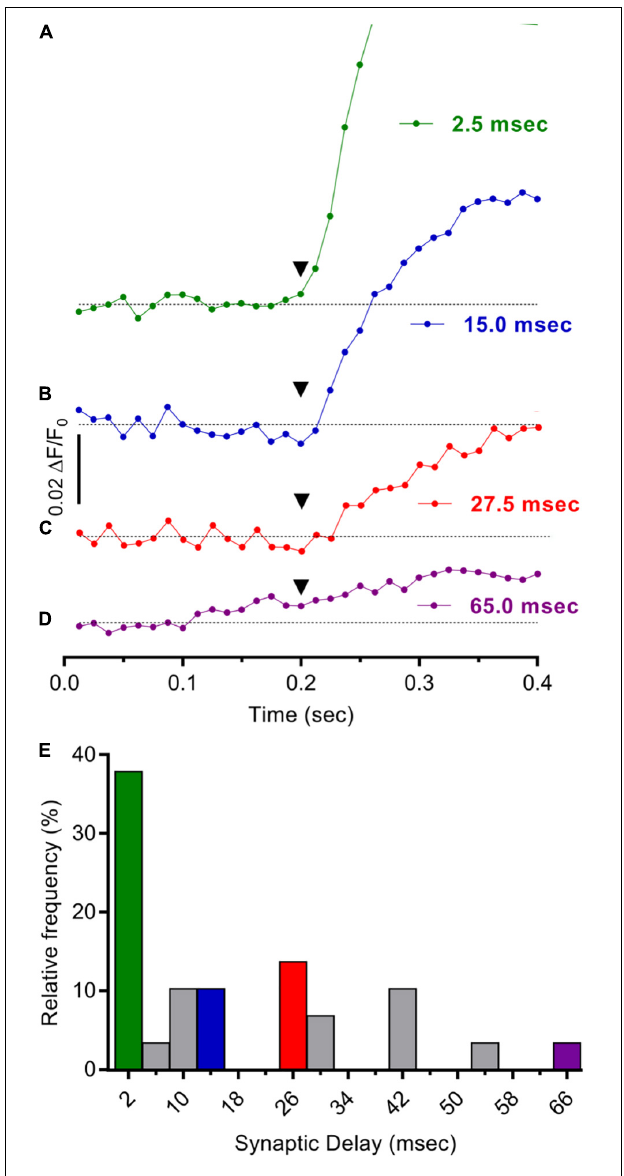
FIGURE 5 | Mono- and poly-synaptic pathways underlie stimulus evoked Ca 2 + responses in cholinergic MG neurons. (A–D) . Individual records depicting expanded time courses of Ca 2 + fluorescence changes sampled at 80 Hz in four GCaMP6f + /ChAT + neurons from a MG following one 1500 µ A stimulus. The time elapsed from stimulus application (inverted black triangles at 200 ms) to response onset [2 × SD of pre-stimulus (cid:49) F/F 0 (response latency)] was determined for each neuron as described in the text. Synaptic delay times were calculated by subtracting the time required for impulse conduction to the recording site [based on a conduction velocity of 0.55 mm/ms (Stebbing and Bornstein, 1996)] from the response latency and were on average 17.7 ± 3.3 ms ( n = 29; N = 2) and 1.5, 15.0, 27.5, and 65.0 ms, respectively, for the neurons depicted in (A–D) . (E) Consistent with the prevalence of monosynaptic inputs, synaptic delay times < 4 ms were most common. Histogram depicts the frequency distribution of synaptic delay times for 29 neurons with colors matching records in (A–D) . Note that the largest fraction of the entries (38%) correspond to synaptic delay times < 4 ms while only 10, 7, and 3% correspond to 15, 27, and 65 ms synaptic delay times,